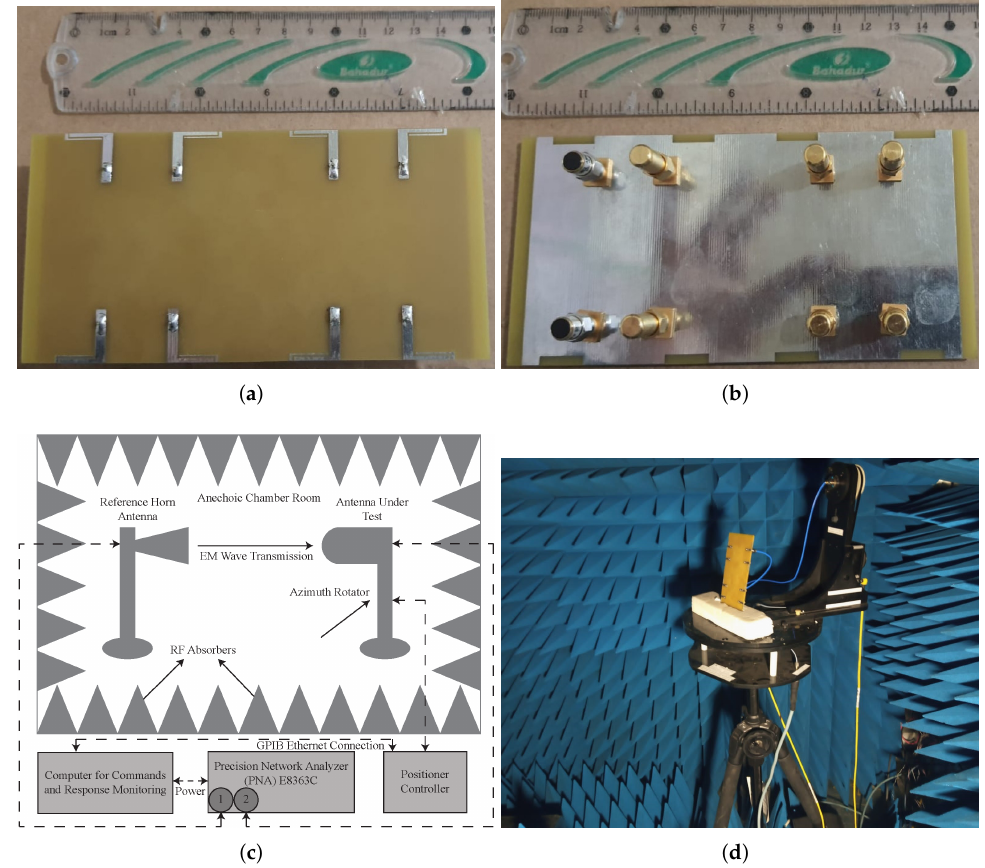
Figure 7. Fabricated prototype of MIMO antenna: ( a ) front; ( b ) back; ( c , d ) antenna far-field measurement setup.